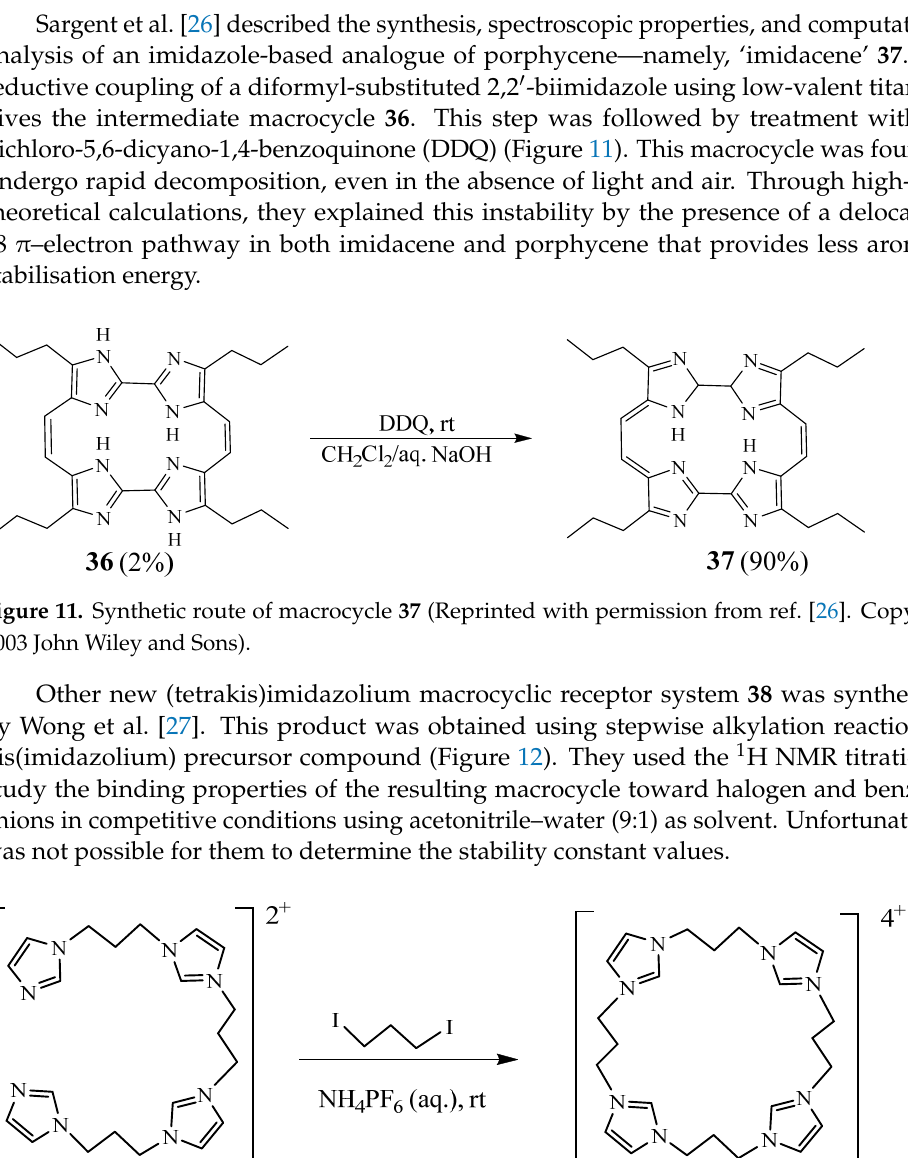
Figure 10. Tetrameric boron–imidazole macrocycles 34 and 35. (Reprinted with permission from ref. [25]. Copyright 2012 Elsevier).